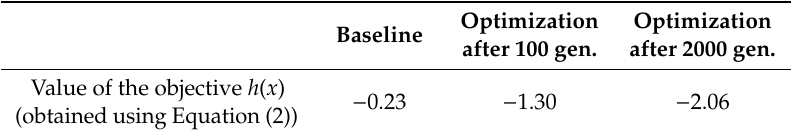
Table 1. Baseline obtained with one-at-a-time parameter modification compared to the results obtained with the proposed optimizational procedure.